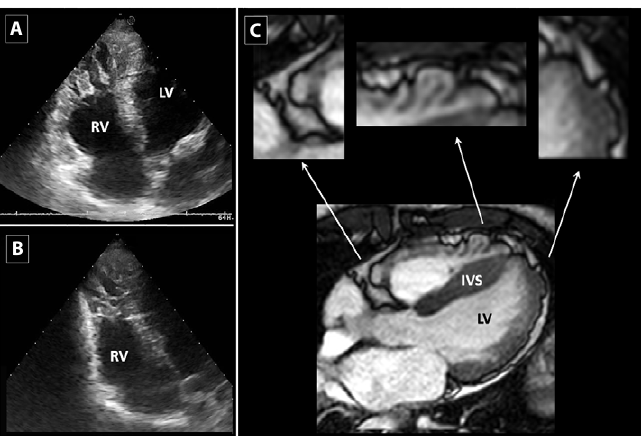
Figure 5. Arrhythmogenic right ventricular cardiomyopathy. 38 year old female with diagnosis of ARVC, resuscitated from out-of-hospital cardiac arrest. She has family history of ARVC (mother) and sudden death (brother, 28 year old). CMR images show clearly wall aneurysms within the so-called ‘‘triangle of dysplasia’’ (panel A–C, white arrows: evident systolic bulging in infundibular, apical, and subtricuspid regions of the RV). Abbreviations: LV = left ventricle, RV = right